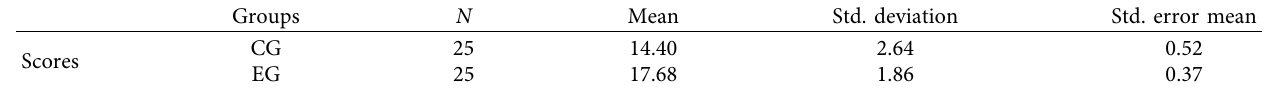
Table 5: Means and standard deviations of both groups on the delayed vocabulary